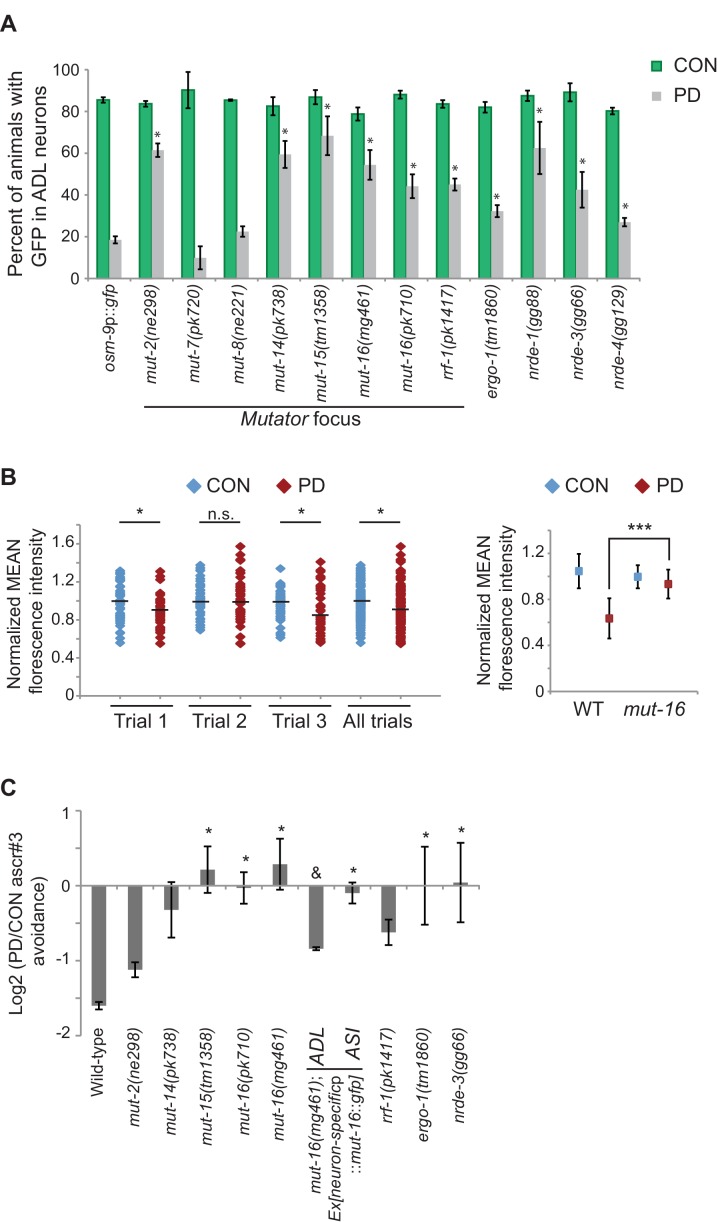
Endogenous RNAi pathways regulate the developmental programming of osm-9 expression and ascr#3 avoidance behavior.(A) Percentage of ADL neurons expressing osm-9p::gfp in wild-type and strains carrying mutations in endo-RNAi genes. Data for additional mutant strains is found in Figure 4—figure supplement 1. N ≥ 2 trials; n ≥ 40 animals (Figure 4—source data 1). * indicates mutant CON or PD significantly different from wild-type; One-way ANOVA with LSD posthoc correction, p<0.05. (B) Quantification of osm-9 mRNA in ADL neurons of mut-16(mg461) CON and PD using smFISH. The graphs represent individual mean fluorescence measurements for N = 3 biologically independent trials; n ≥ 129 neurons (Figure 4—source data 2). Maximum florescent measurements are found in Figure 4—figure supplement 3. Control gfp mRNA measurements are found in Figure 4—figure supplement 4. Medians are indicated. Comparison of means with S.E.M. of all trials for CON and PD in wild-type and mut-16 is shown. *p<0.05, ***p< 10–14, Student’s t-test. (C) Log2 PD/CON ratio of ascr#3 avoidance behavior in wild-type and strains carrying mutations in endo-RNAi genes. Data for ADL and ASI-specific expression of mut-16 rescue are averages of two extrachromosomal lines. N ≥ 3 trials; n ≥ 60 animals (Figure 4—source data 3). * indicates PD/CON ratio significantly different from wild-type; & indicates PD/CON ratio significantly different from mut-16(mg461); One-way ANOVA, LSD posthoc correction, p<0.05. All error bars represent S.E.M. Data for controls is found in Figure 3—figure supplement 2.DOI:
http://dx.doi.org/10.7554/eLife.11642.02410.7554/eLife.11642.025Figure 4—source data 1.Spreadsheet containing percentages of animals expressing osm-9p::gfp in ADL neurons in strains carrying mutations in genes with RNAi functions.DOI:
http://dx.doi.org/10.7554/eLife.11642.02510.7554/eLife.11642.026Figure 4—source data 2.Spreadsheet containing raw and normalized mean florescence intensities of osm-9 smFISH probes in ADL neurons in mut-16(mg461) strain.DOI:
http://dx.doi.org/10.7554/eLife.11642.02610.7554/eLife.11642.027Figure 4—source data 3.Spreadsheet containing PD/CON ascr#3 avoidance ratios for strains carrying mutations in genes with RNAi functions.